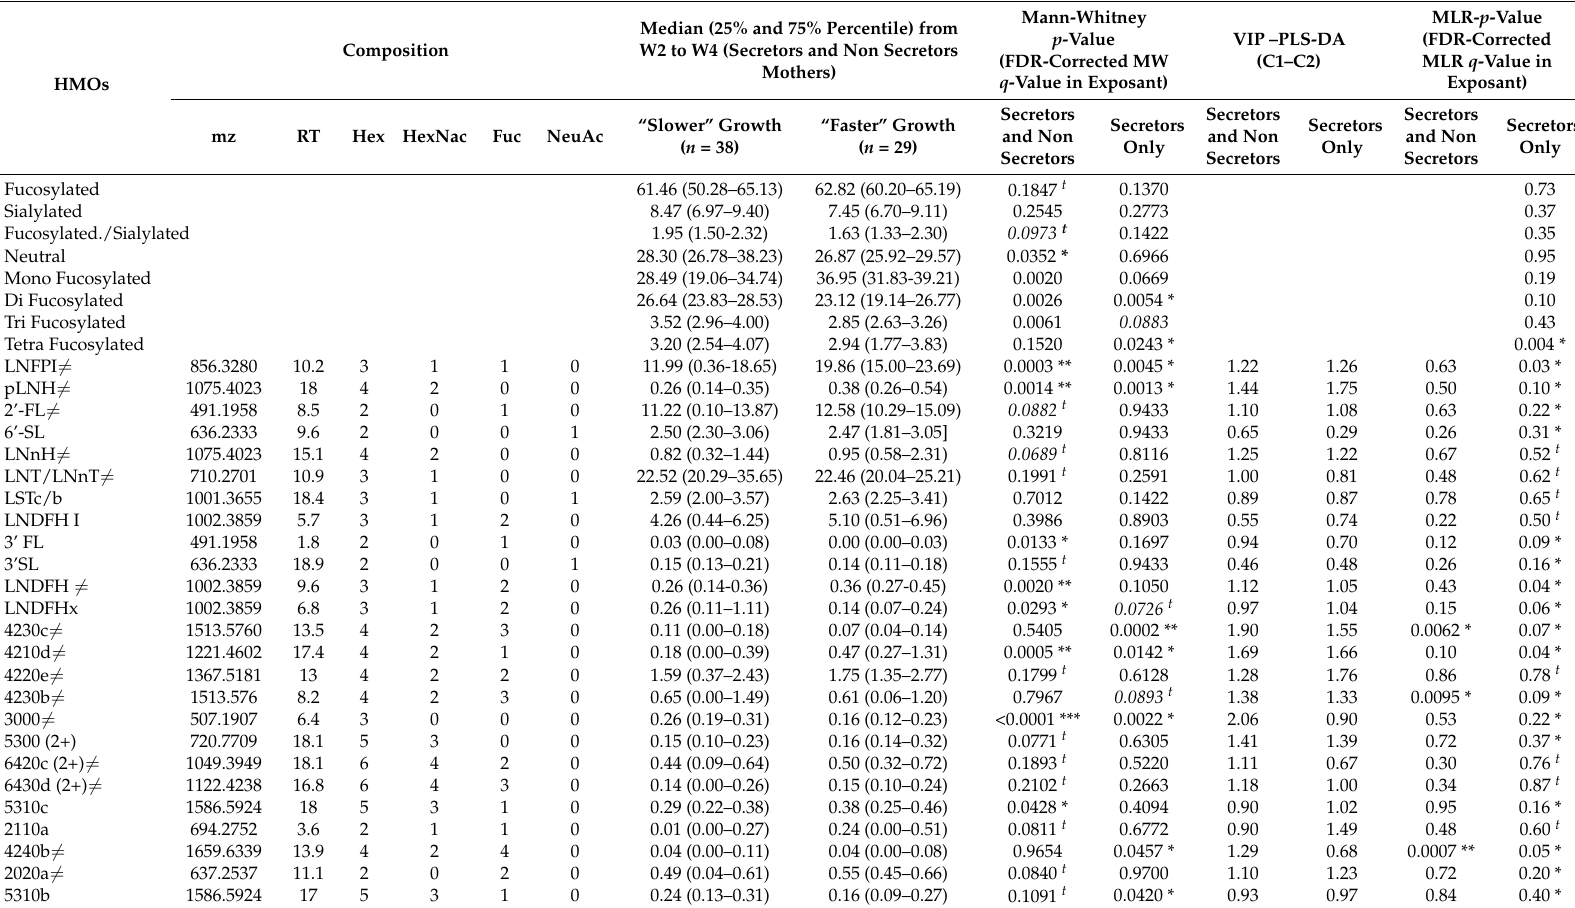
Table 4. Major HMOs detected in breast milk glycome and provided to preterm infants with “faster” or “slower” growth during the W2 to W4 lactation